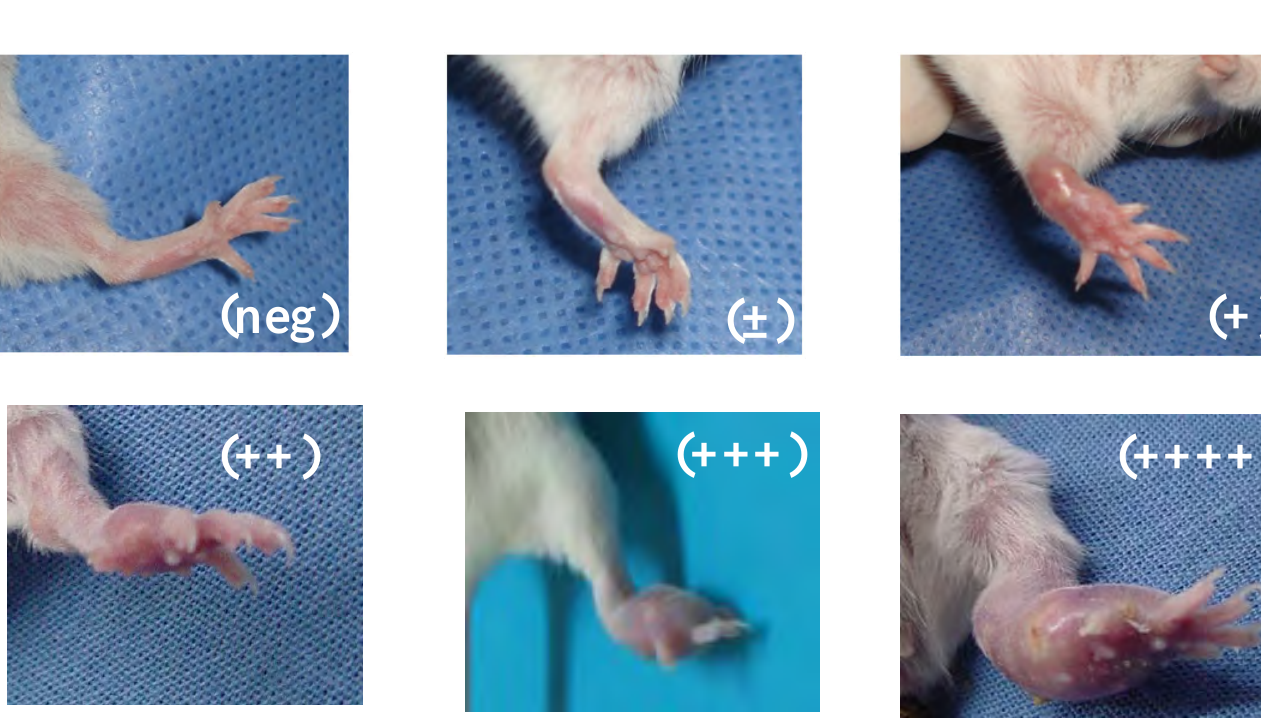
Figure 3. BALB/c mice inoculated with N. brasiliensis HUJEG-1 showing diverse degrees of mycetomatous lesions. The lesions were scored from those without inflammatory changes (identical to the non-inoculated foot pad), to those presenting extense, abscedated lesions over the metatarsal